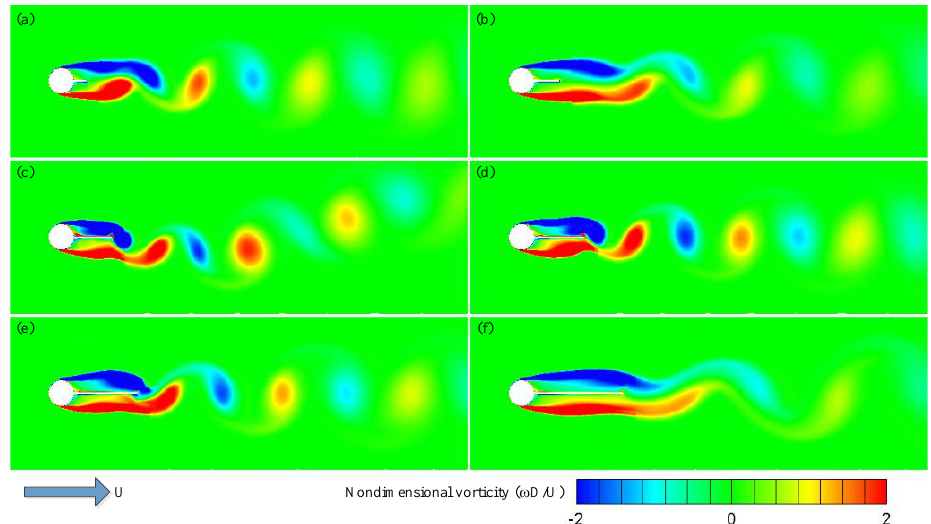
Figure 6. Wake structures in the form of nondimensional vorticity at U = 1.7 m/s for various plate lengths: ( a ) L ∗ = 0.5; ( b ) L ∗ = 1; ( c ) L ∗ = 1.5; ( d ) L ∗ = 2; ( e ) L ∗ = 2.5 and ( f ) L ∗ =